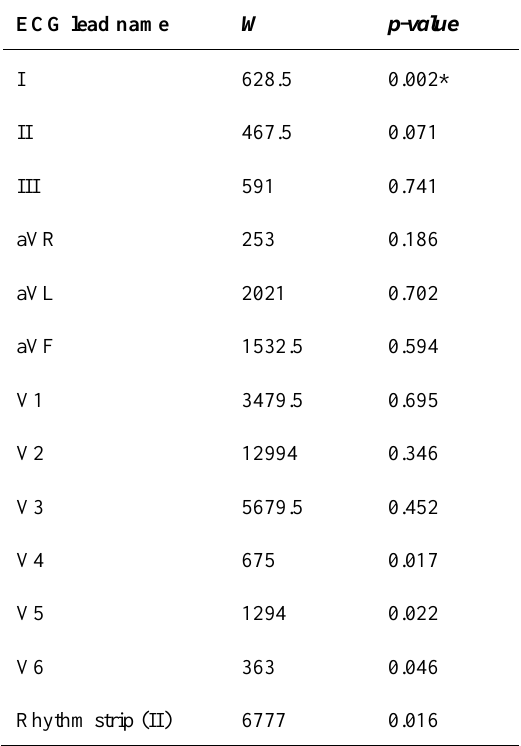
Table 3. Pairwise comparisons for each lead (Mann-Whitney U) with Bonferroni correction α = 0.004.